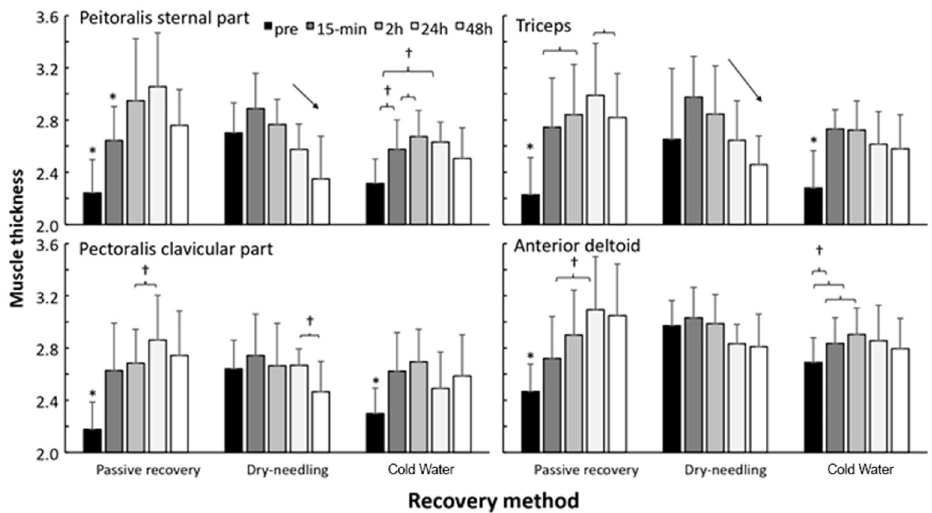
Figure 5. Mean ( ± SEM) differences in muscle thickness measured with ultrasound before and after 15 min, 2 h, 24, and 48 h exercise-induced muscle damage and recovery (passive, dry-needling, or cold-water immersion) protocol for triceps, pectoralis clavicular, sternal part, and anterior deltoid muscles. Muscle thickness (cm). * indicates a significant difference with all other test occasions ( p < 0.05). † indicates a significant difference between these two test occasions. ( p < 0.05) indicates a significant change between these test moments for this protocol on a p < 0.05 level.